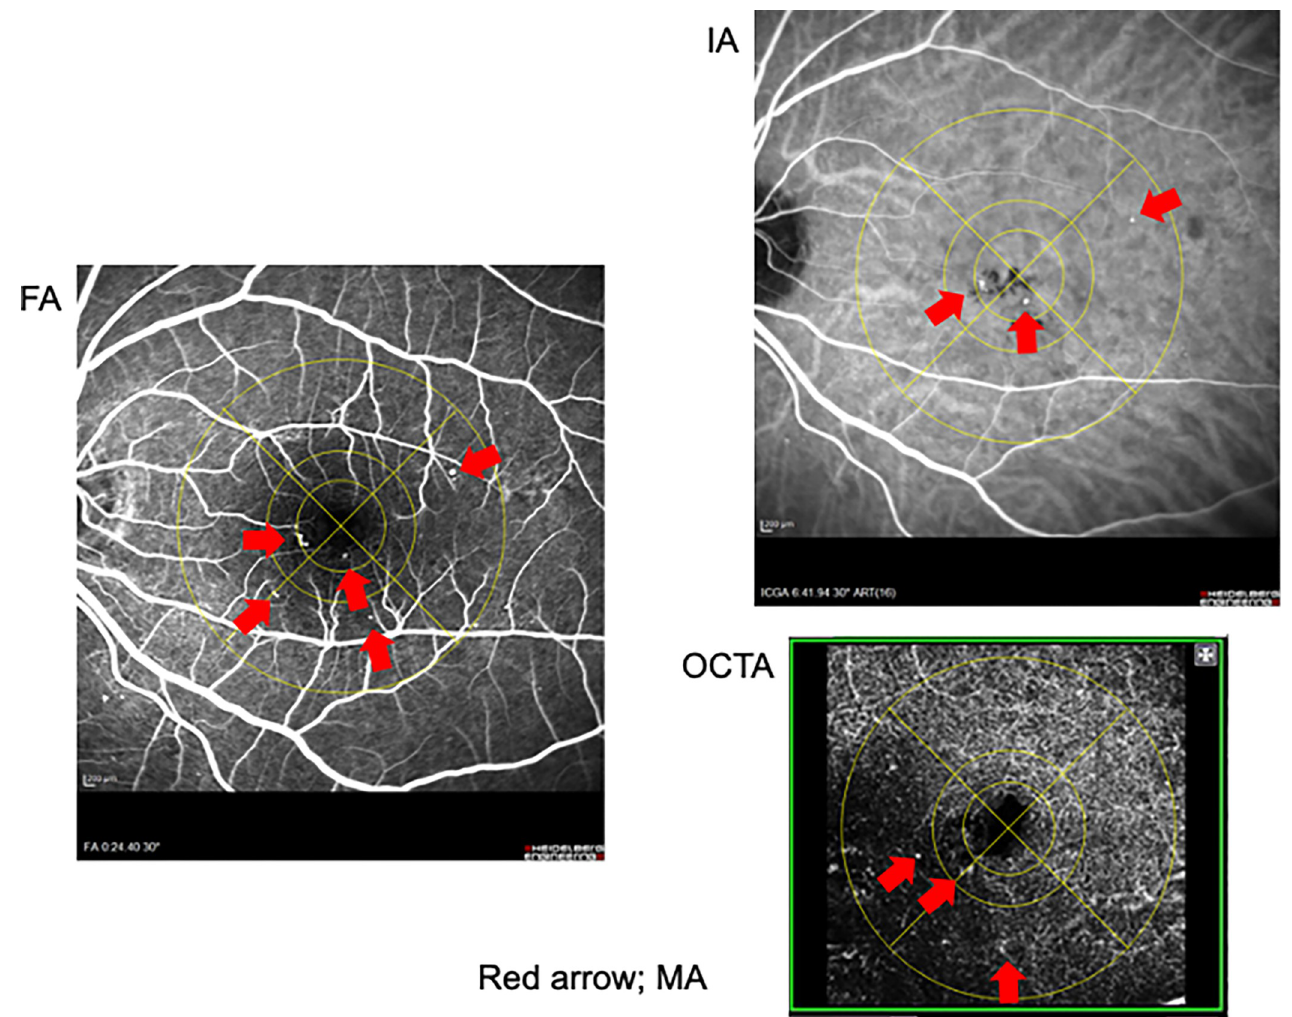
Fig 2. Detected MA of a patient. There are MAs in each the modified ETDRS grid areas. Red arrows indicate